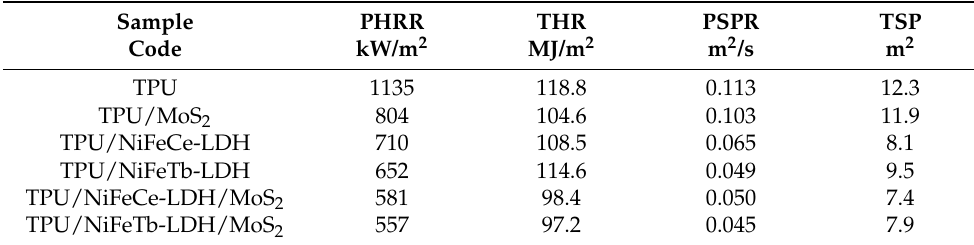
Table 1. Cone calorimeter data of TPU